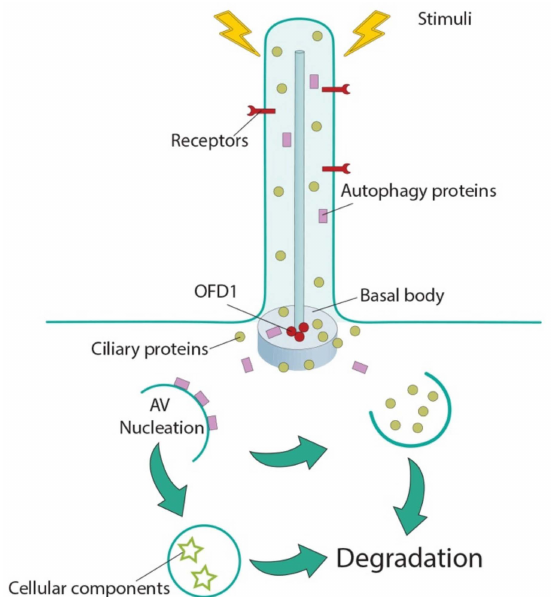
Figure 1. Cilia-autophagy crosstalk. Cilia sense external stimuli and transduce them into the cell to influence macroautophagy, possibly utilizing the autophagic machinery localized in the peri-ciliary compartment. On the other side, autophagosomes influence ciliogenesis by selective autophagic degradation of ciliary positive and / or negative e ff ectors as cargoes. AV: autophagic vacuoles; ciliary proteins: green circles; OFD1: red circles; autophagic proteins: purple rectangles; cellular components: